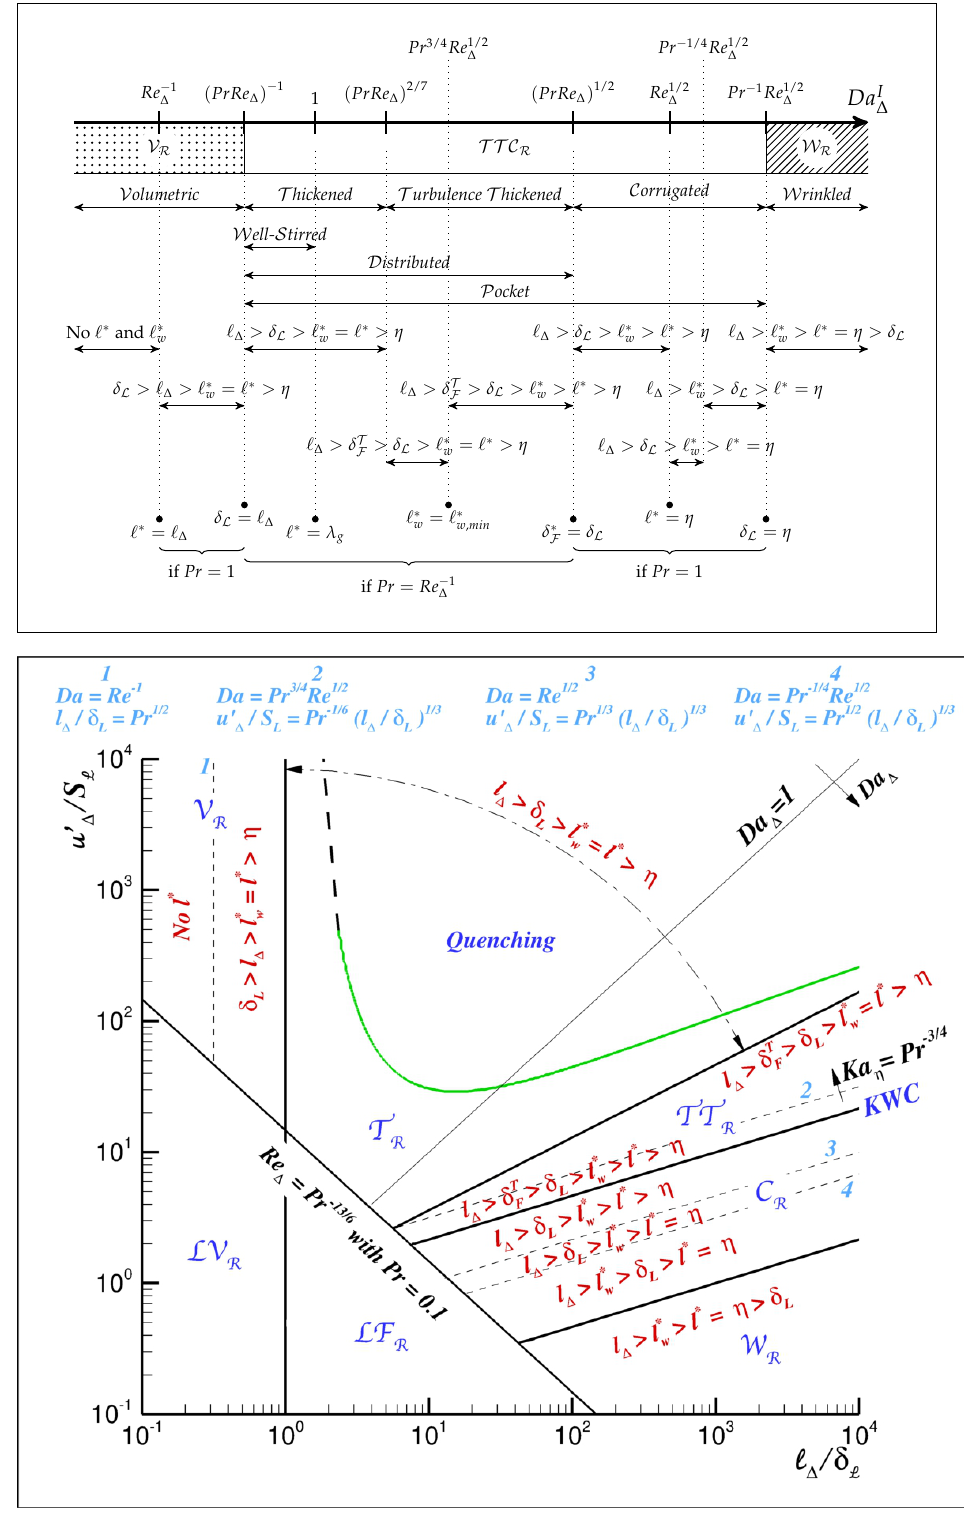
Figure 6. Description of the LTSM framework for 1 ≥ Pr ≥ Re − 6/13 ∆ also provided in the standard combustion diagram style, with Pr = 0.1 chosen as an example to draw the lines. The quenching region as derived through the quenching cascade model is also